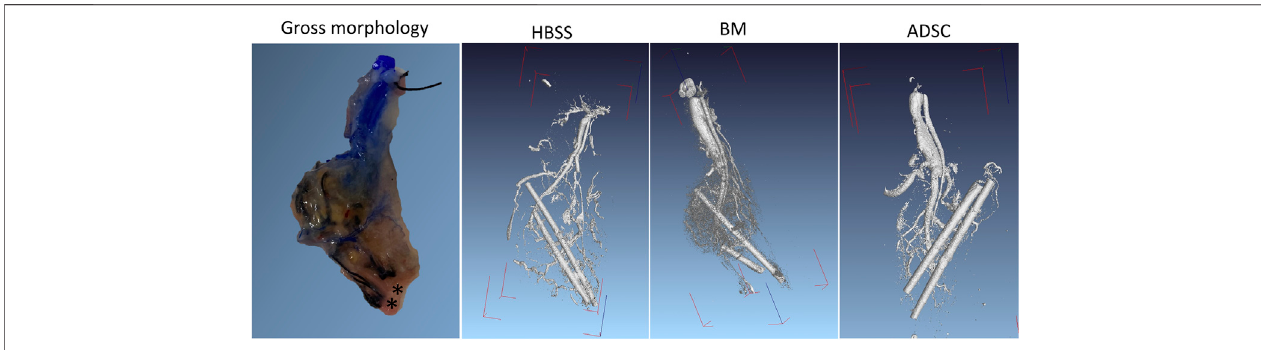
FIGURE 8 | Ex vivo micro-CT imaging. Ex vivo micro-CT was performed in one rat per group after injecting Micro fi l through the abdominal aorta. The DICOM fi les were reconstructed using a visual studio software program. The PV and HA cannulas were left in place for orientation (radioopaque). The gross morphology of the graft after Micro fi l injection is provided for anatomical correlation (the asterixis mark the cannulas ’ location).